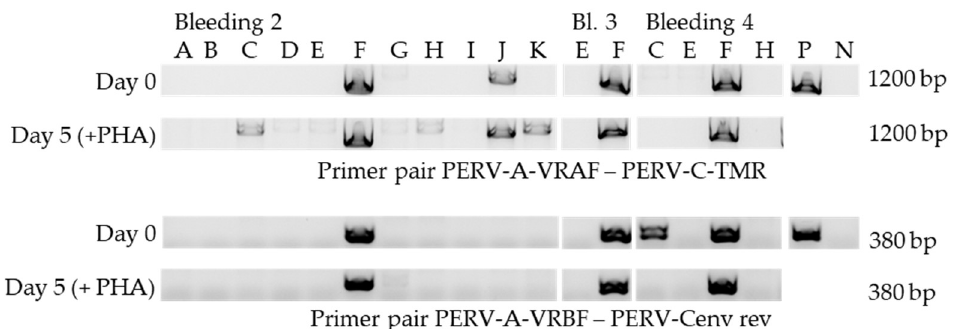
Figure 4. Detection of PERV-A/C proviruses in GöMP from the Göttingen University. PBMCs from three consecutive bleedings (bleedings 2, 3 and 4) were isolated and tested at day 0 and after 5 days of cultivation with PHA. Two primer pairs were used resulting in overlapping amplicons (Figure 2). 11 pigs (A–K) were analyzed, as well as a PERV-A/C plasmid PERV-A 14/220 ([37], AY570980) (P) and as negative control (N) water.